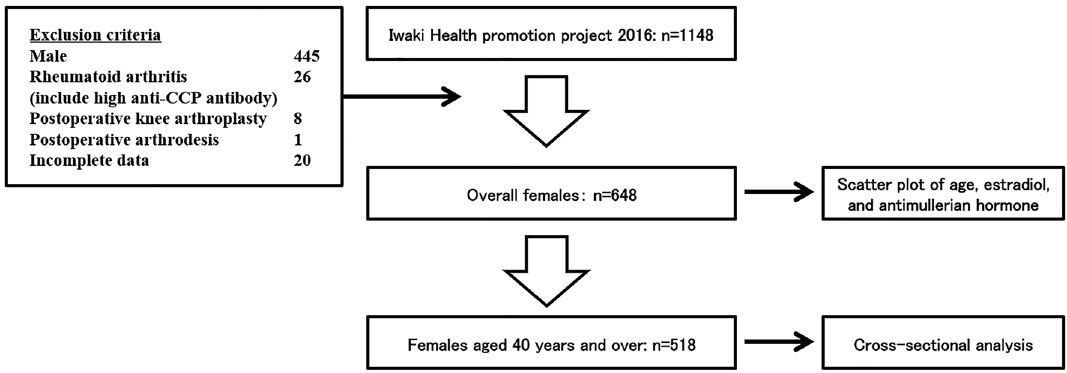
Figure 1. Flow of participants enrollment in Iwaki Health promotion project. Finally, 518 females were enrolled for the statistical